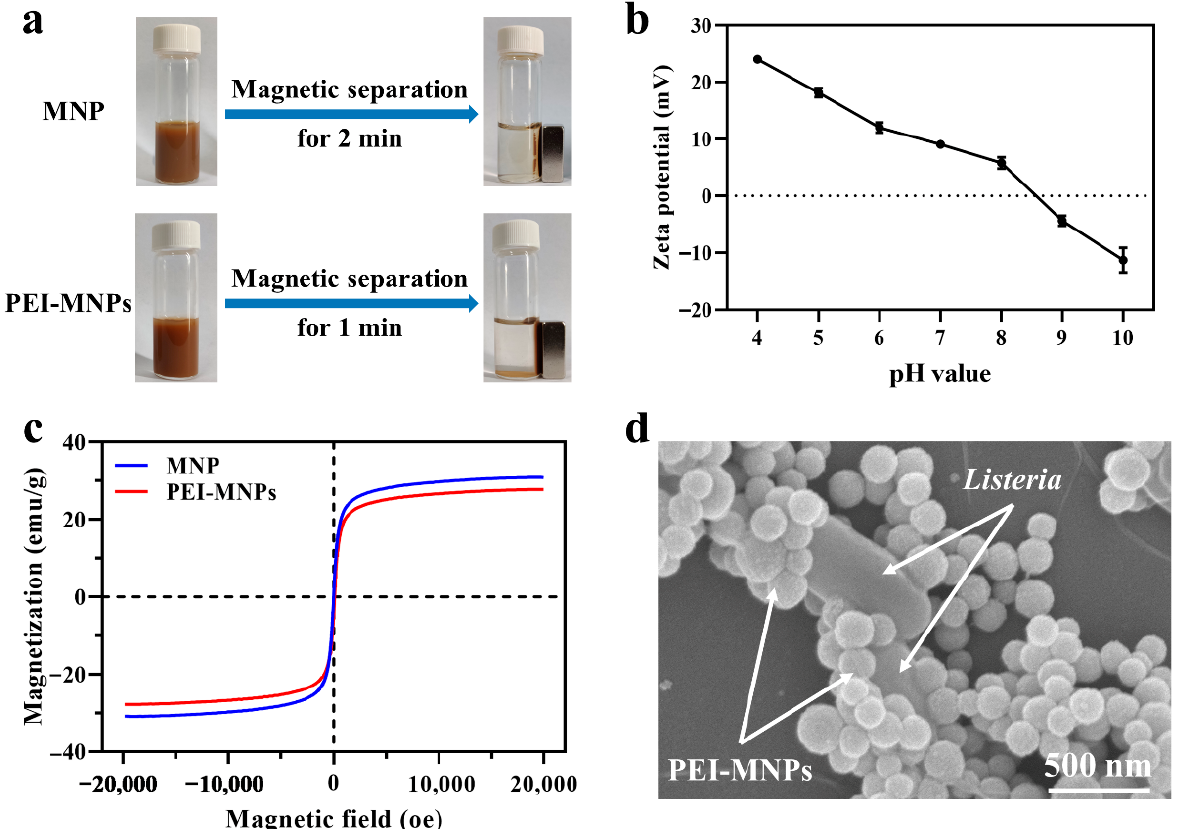
Figure 2. Characterization of MNP and PEI-MNPs. ( a ) Photo of MNP and PEI-MNPs adsorption under the action of a magnet. ( b ) Zeta potential of PEI-MNPs at pH 4 to 10. ( c ) Magnetic hysteresis loops of MNP and PEI-MNPs measured at room temperature. ( d ) SEM image of PEI-MNPs bound to the surface of Listeria .